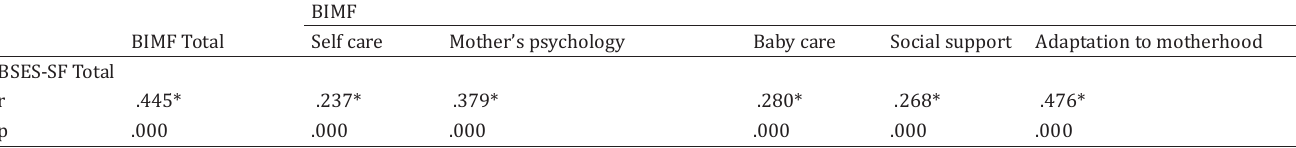
Relation between Score Averages which Puerperants Obtained in BIMF and BSES-SF Total and Sub-dimensions (n=444)